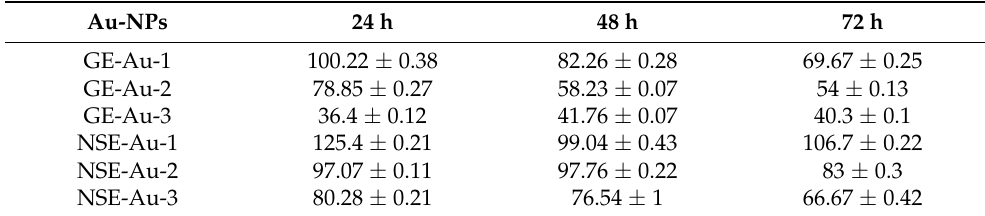
Table 2. IC50 values ( µ g/mL) of various concentrations of GE- and NSE-conjugated Au-NPs against MDA-MB-231 breast cancer cell lines at different